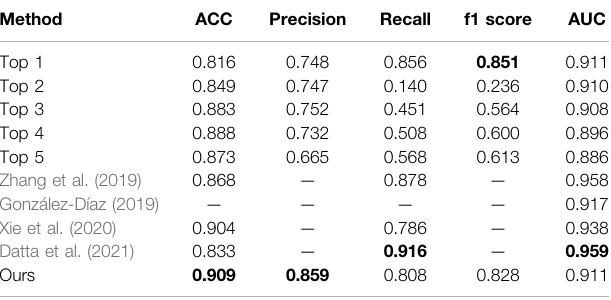
TABLE 6 | Comparison among our method, some existing methods, and the top fi ve ISIC2017 classi fi cation challenge.